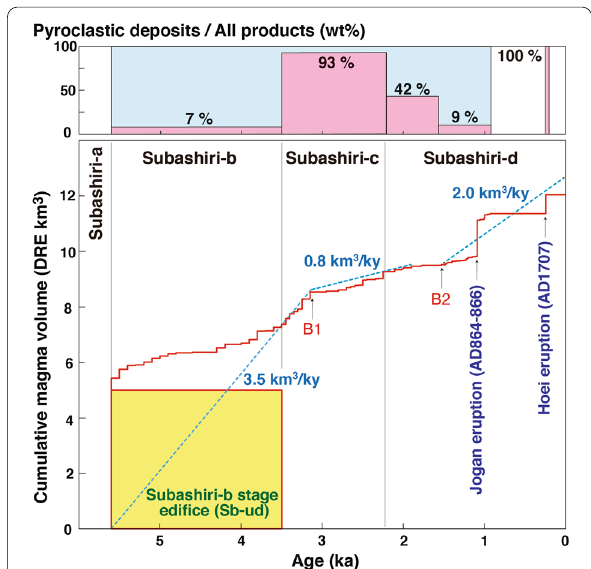
Fig. 2 Cumulated eruptive magma volumes and ratio of pyroclastic to all eruptive products. Because the volume of the Subashiri-b stage edifice cannot be subdivided for each eruption, the total volume is shown spanning the entire Subashiri-b stage. The eruptive volume and age of each eruption event is listed in (Additional file 1: Table S1). Blue dashed lines indicate the average eruption rate. B1 and B2